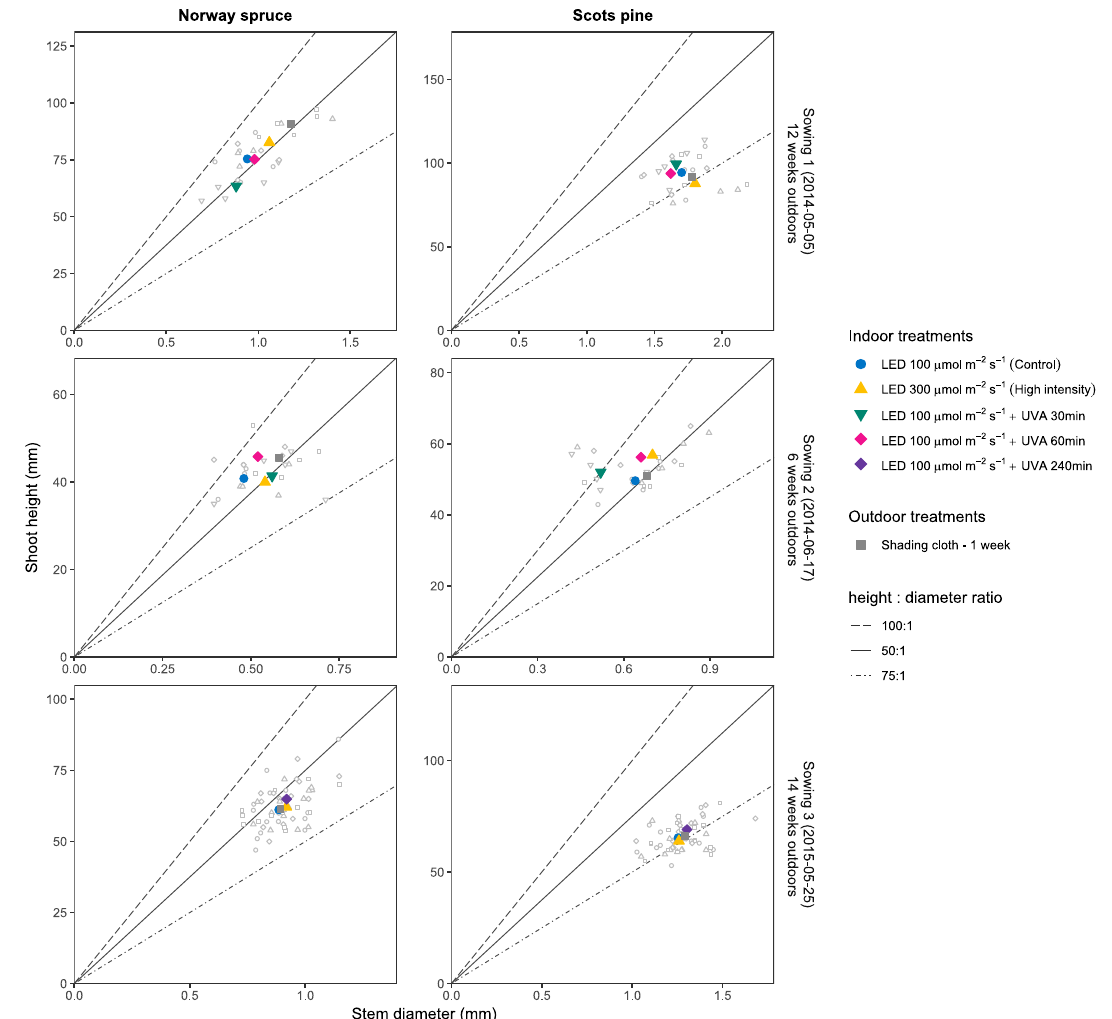
Figure 6. Average sturdiness evaluated in function of the height:diameter ratio after the first vegetation period for seedlings of Norway Spruce (left) and Scots pine (right). Each panel row shows the results for one individual sowing with colored shapes representing the mean of each treatment in ordered pairs (x = stem diameter (mm), y = shoot height (mm)) and smaller points show the individual seedling measurements. Lines mark the different height:diameter ratios (100:1, 75:1, 50:1). For Sowing 1 and Sowing 2 the UVA treatments (30 and 60 min) were different from Sowing 3 which only included the UVA 240min treatment as explained in the Materials and Methods Section.